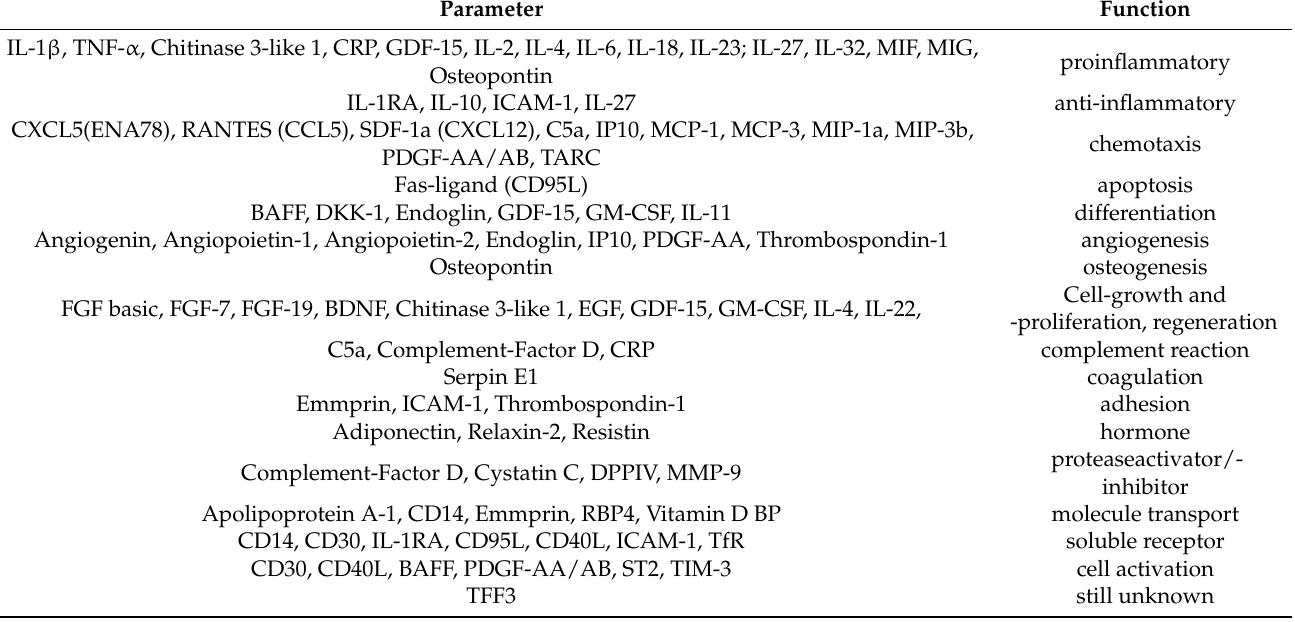
Table 4. Expressed parameters without significant differences between groups and assignment to functional categories.